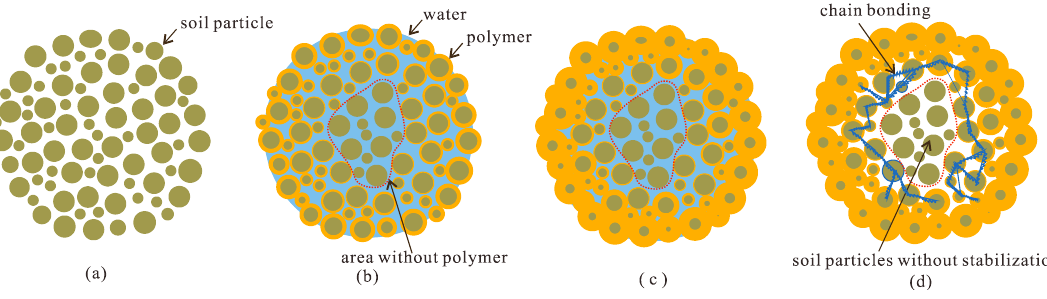
Figure 9. Illustration of the infiltration and stabilization mechanism of the polymer emulsion on the surface of the soil aggregates: ( a ) untreated aggregate; ( b ) polymer emulsion infiltrated the soil; ( c ) polymers gathered on the surface; ( d ) soil-polymer matrix formed after water evaporating.